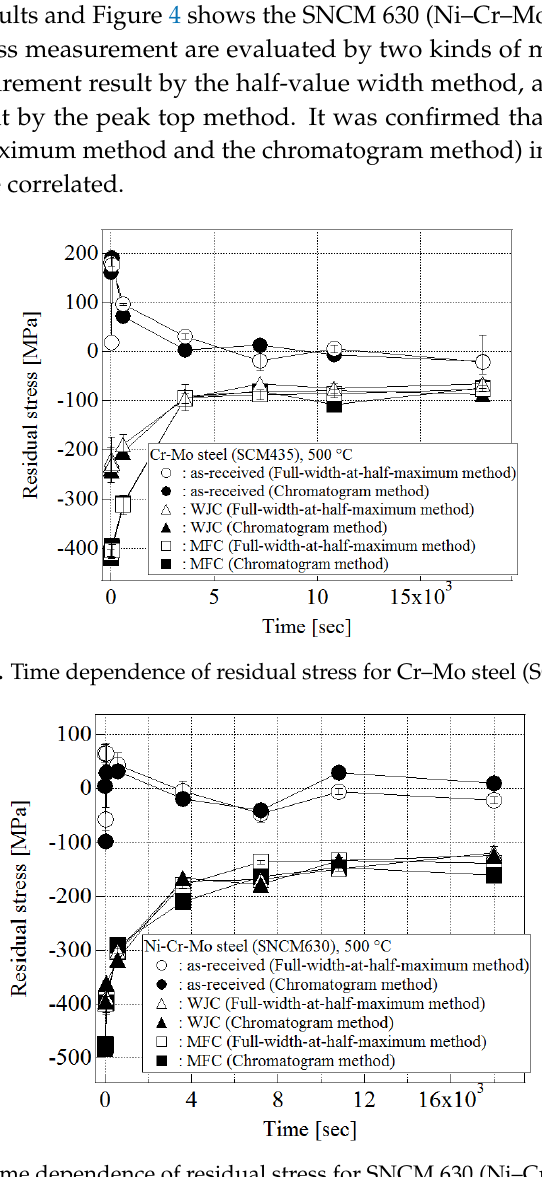
Figure 4. Time dependence of residual stress for SNCM 630 (Ni–Cr–Mo steel).